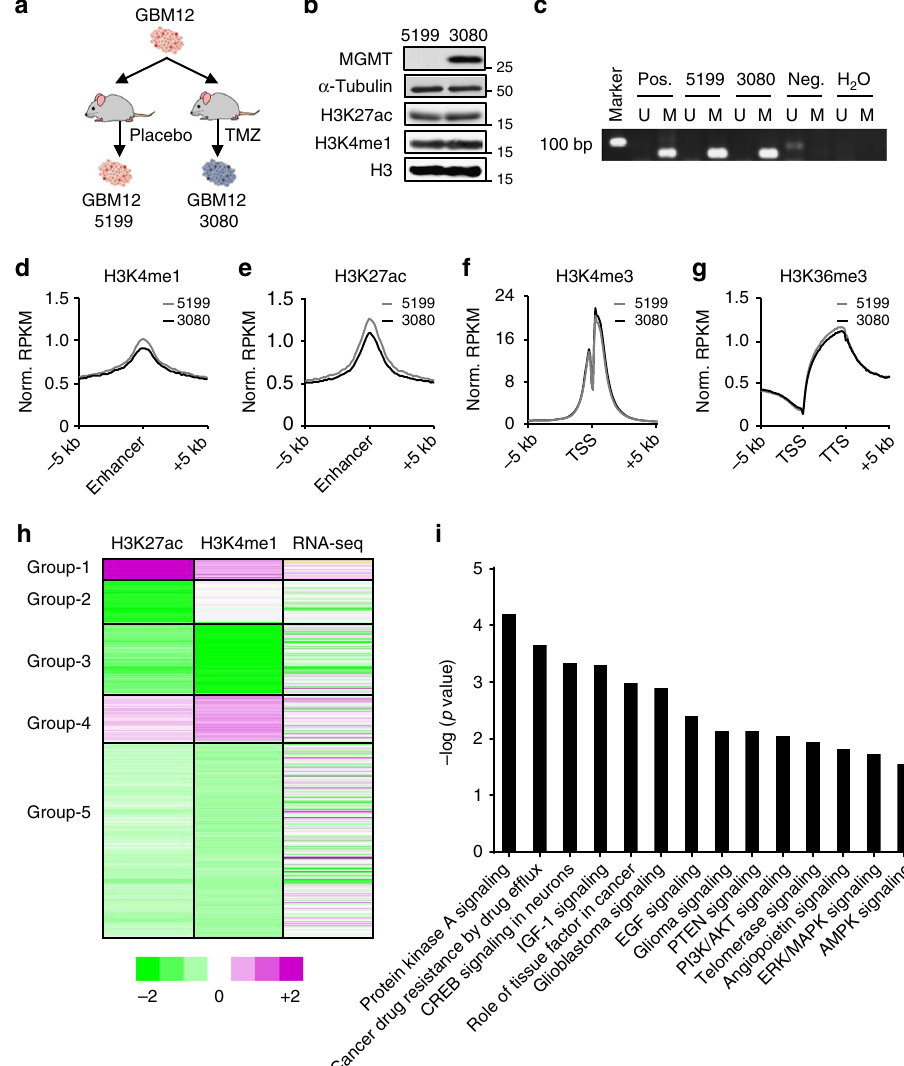
Fig. 1 Enhancer marks are altered in a TMZ-resistant PDX line. a Schematic diagram for the development of 5199 and 3080 xenograft lines from parental GBM12 cells. Mice with GBM12 fl ank tumors were treated with placebo or three cycles of TMZ (50 mg/kg/d for 5 days every 28 days). Tumors were dissected after reaching >1500 mm 3 . The xenograft subline established from placebo-treated tumor was named 5199 and that from TMZ-treated tumor was named 3080. b Analysis of MGMT, H3K27ac and H3K4me1 levels in protein lysates of 5199 and 3080 xenograft tissues by western blotting. α -tubulin and histone H3 was used as a loading control for cytosolic proteins and nuclear proteins, respectively. c Analysis of MGMT promoter methylation in 5199 vs. 3080 xenograft lines by MS-PCR. Universal methylated DNA was used as positive control and normal human brain DNA was used as negative control. d – g Aggregate plots showing the average ChIP-seq reads distribution for the various histone marks: H3K4me1 ( d ) and H3K27ac ( e ) ChIP-seq reads surrounding the published enhancer regions; H3K4me3 ( f ) ChIP-seq reads surrounding transcription start site (TSS); H3K36me3 ChIP-seq reads across gene bodies ( g ). TTS: transcription termination site. h Heat maps showing cluster analysis, based on H3K27ac and H3K4me1 alterations, and expression change for genes closest to each genomic locus. The ratio of ChIP-seq reads density (3080 reads/5199 reads) for H3K4me1 and H3K27ac was calculated and subsequently analyzed by k-means cluster analysis. Changes in gene expression were calculated as RNA-seq reads ratio (3080 reads/5199 reads). Color scale represents decreased (green) and increased (magenta) signal intensity (intensity = log 2 3080 reads . i Bar graphs showing ingenuity pathway 5199 reads ) analysis for Group-1 genes. Pathways with a p value <0.05 are